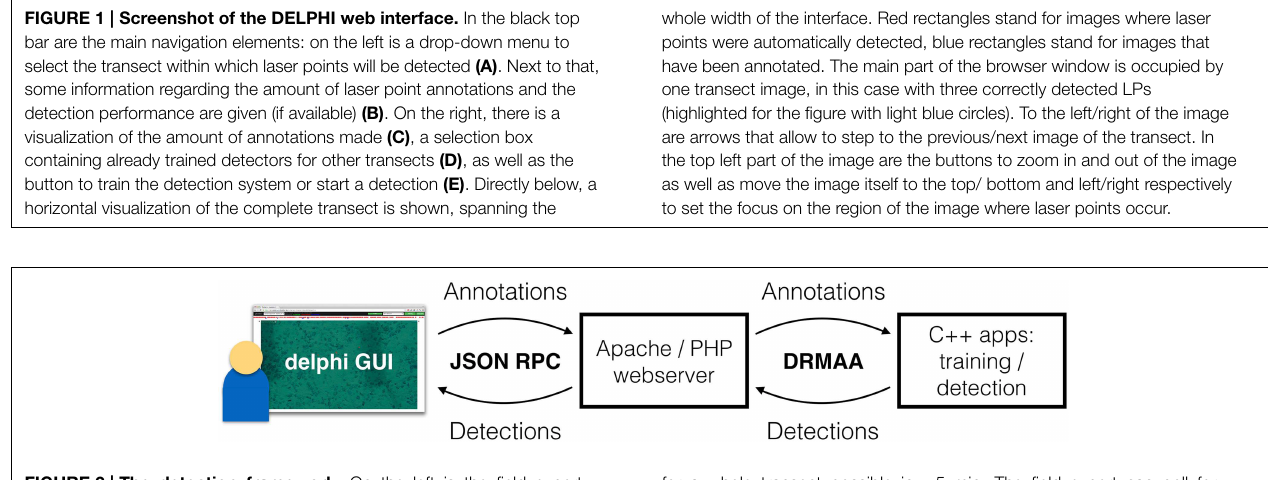
FIGURE 2 | The detection framework. On the left is the field expert, interacting with the DELPHI GUI in a web browser. The annotations are transferred via JSON RPC to a web server. This server then starts the training process, which takes ca. 2 min. Afterwards (or in case an already trained detection system is applied), the web server schedules a detection process on the compute server. This makes the LP detection